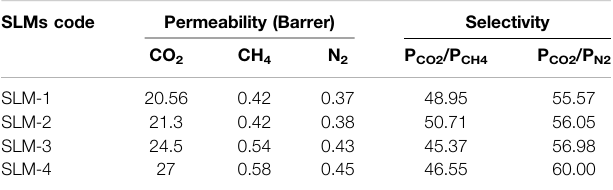
TABLE 3 | CO 2 /CH 4 and CO 2 /N 2 ideal gas permeability and selectivity. SLMs code